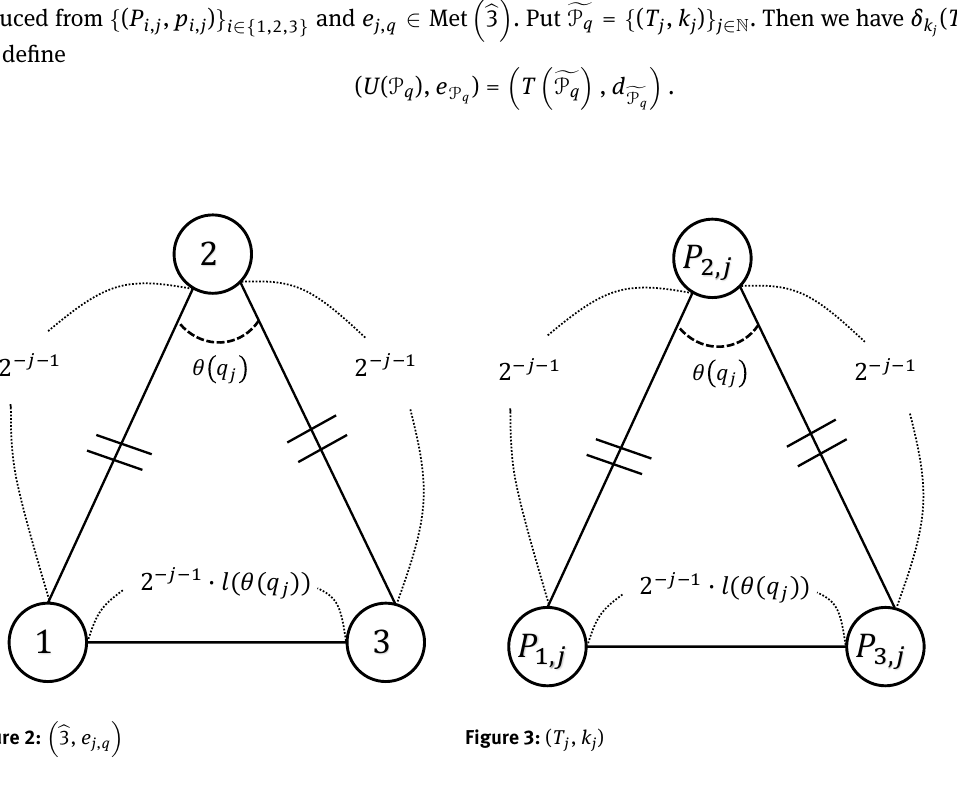
Figure 3: ( T j , k j